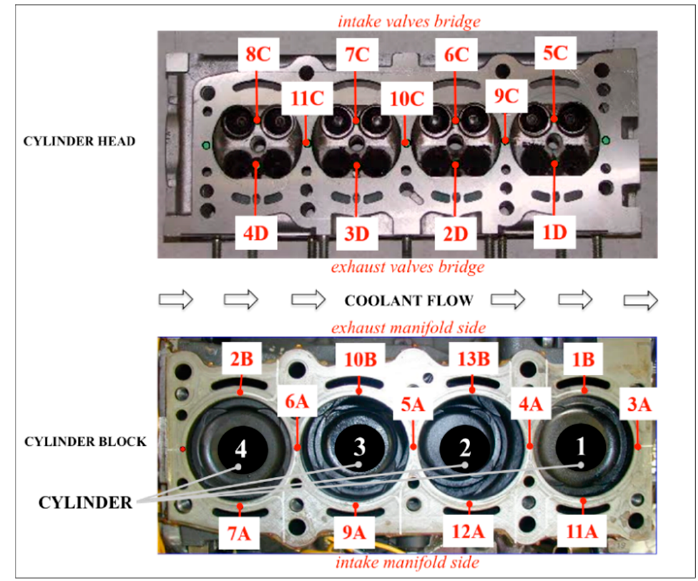
Figure 5. Thermocouple positions in engine head and block.